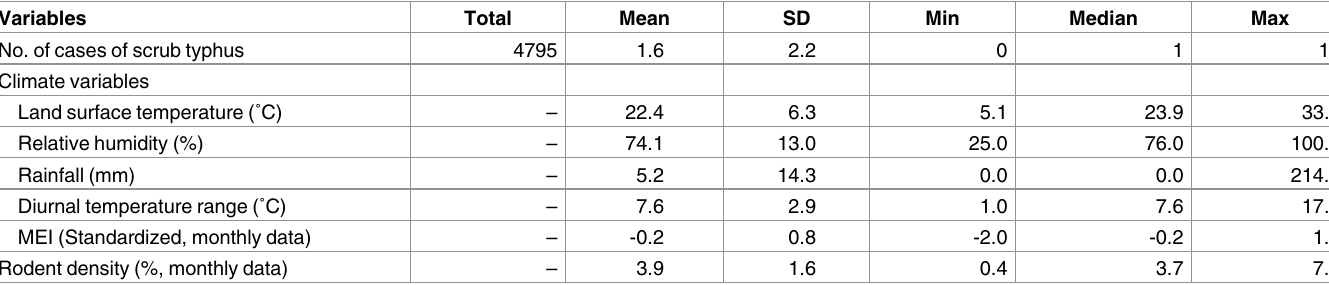
Table 1. Descriptivestatistics for daily scrub typhus cases and climate variables,in Guangzhou, Southern China, 2006–2013.